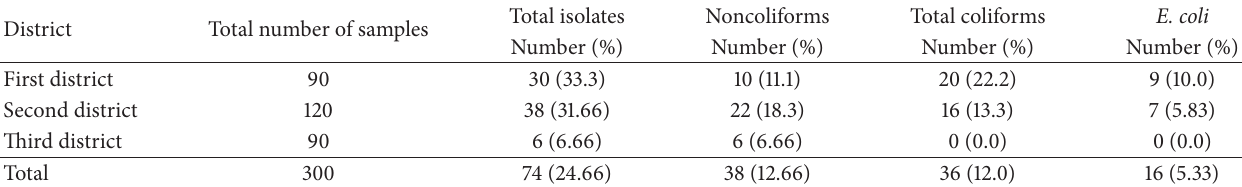
Table 2: Distribution of noncoliforms, coliforms, and E. coli among the three districts.